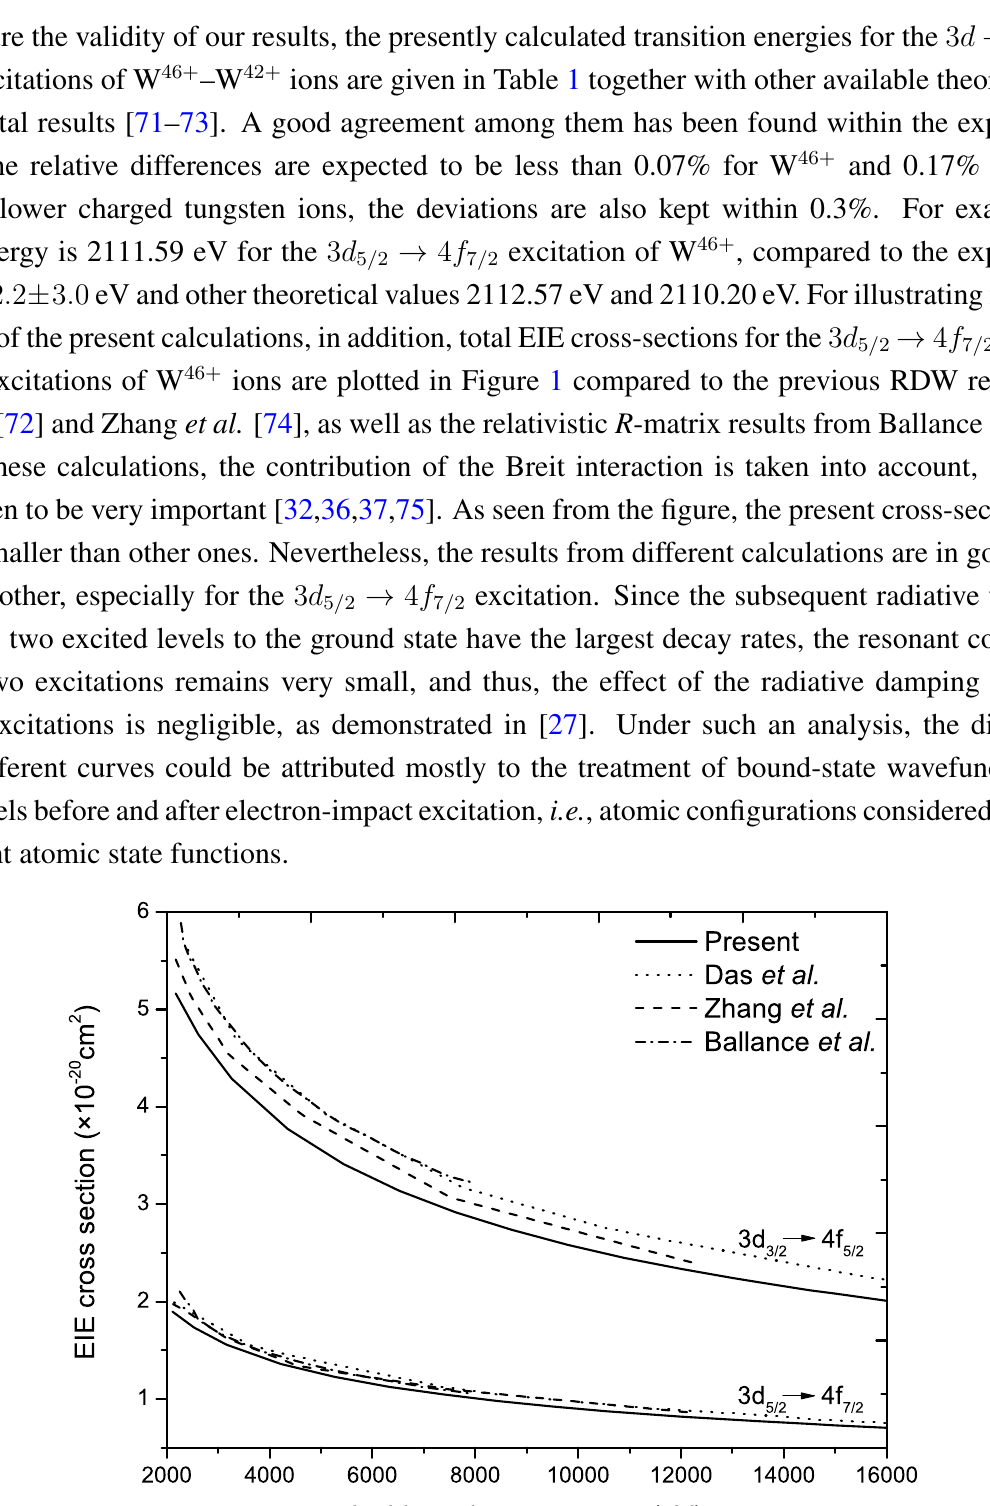
Figure 1. The presently calculated total cross-sections for the 3 d